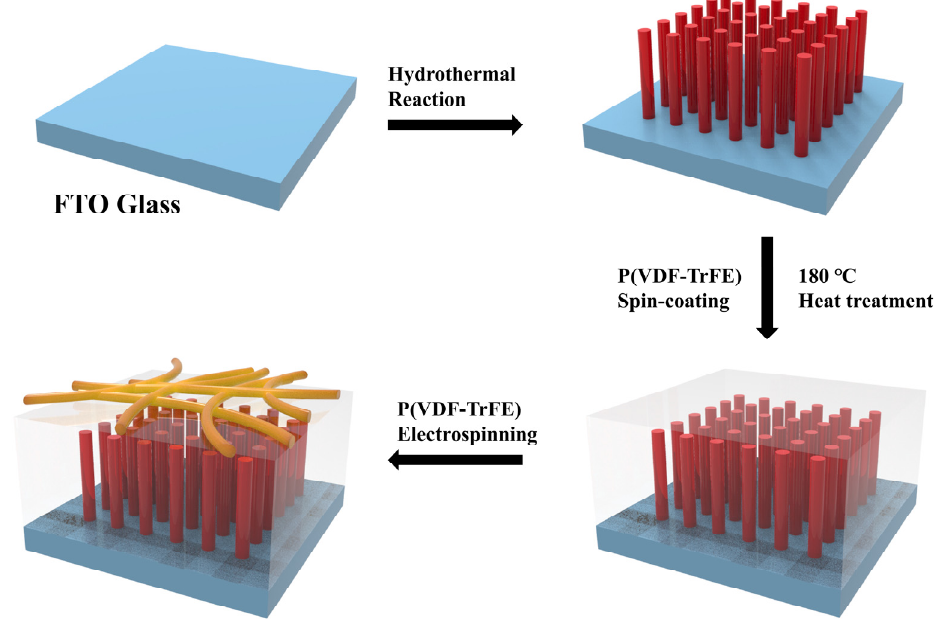
Figure 2. The fabrication process of the PVTNF-PVT/ TiO 2 nanowire arrays (TNA) composite. A parameter TiO 2 Nanowire (TN) is introduced to distinguish different samples, which refers to the ratio of the length of TiO 2 nanowires and the thickness of the composite. The TN of the composites are shown in Table 1. According to the different thickness of P(VDF-TrFE), the samples can be named as TN-0.769, TN-0.667, TN-0.594 and TN-0.396. In addition, a pure P(VDF-TrFE) spin-casted film without electrospinning process named as TN-0.000, and a TiO 2 nanowire array on FTO glass named as TN-1.000 were prepared as contrast samples. Table 1. The TiO 2 nanowire lengths, film thickness and TN of composites.